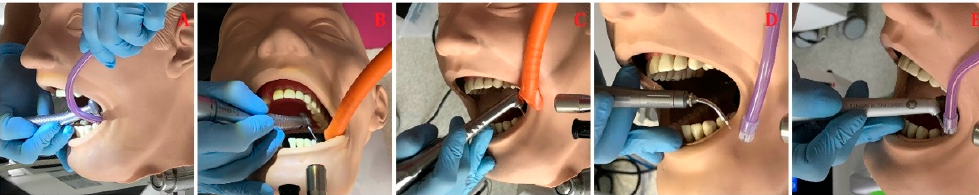
Figure 3. Caries’ removal by conventional handpieces and Er:YAG lasers: ( A ) a high-speed handpiece; ( B ) a low-speed handpiece; ( C ) LightWalker; ( D ) AdvErL Evo; ( E ) LiteTouch.